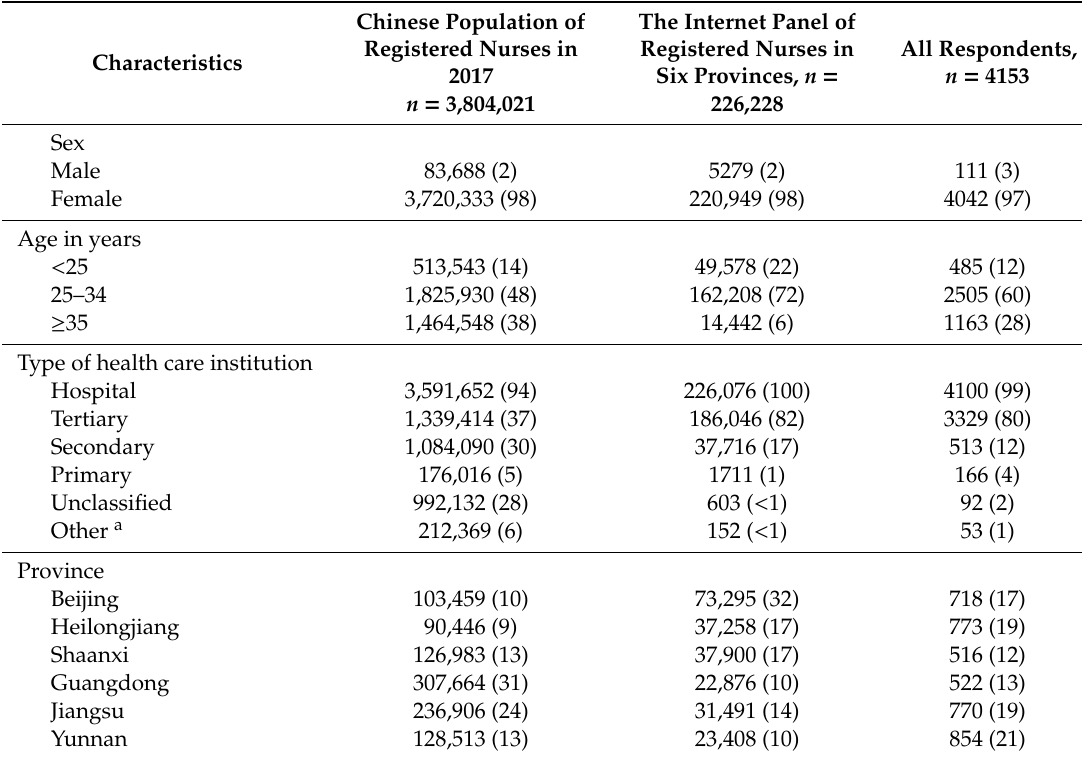
Table 1. Characteristics of registered nurse internet panel survey respondents, China, 2017 /